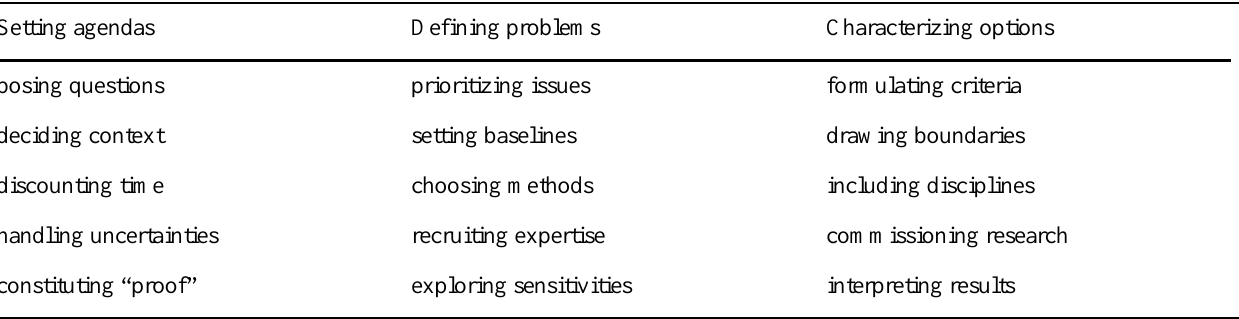
Table 1 . A selection of factors influencing the framing of scientific risk